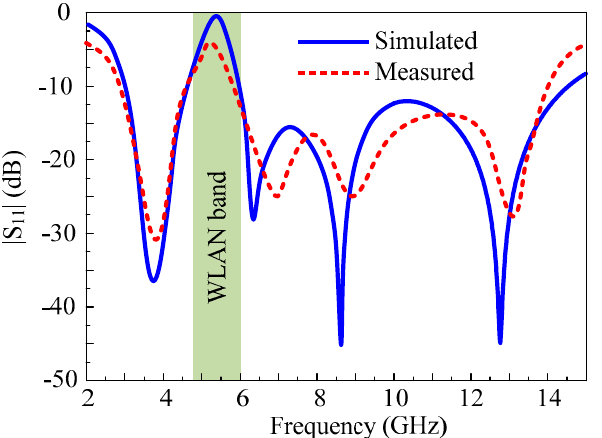
Figure 5. Measured and simulated |S 11 | of the proposed notch band extended UWB antenna.